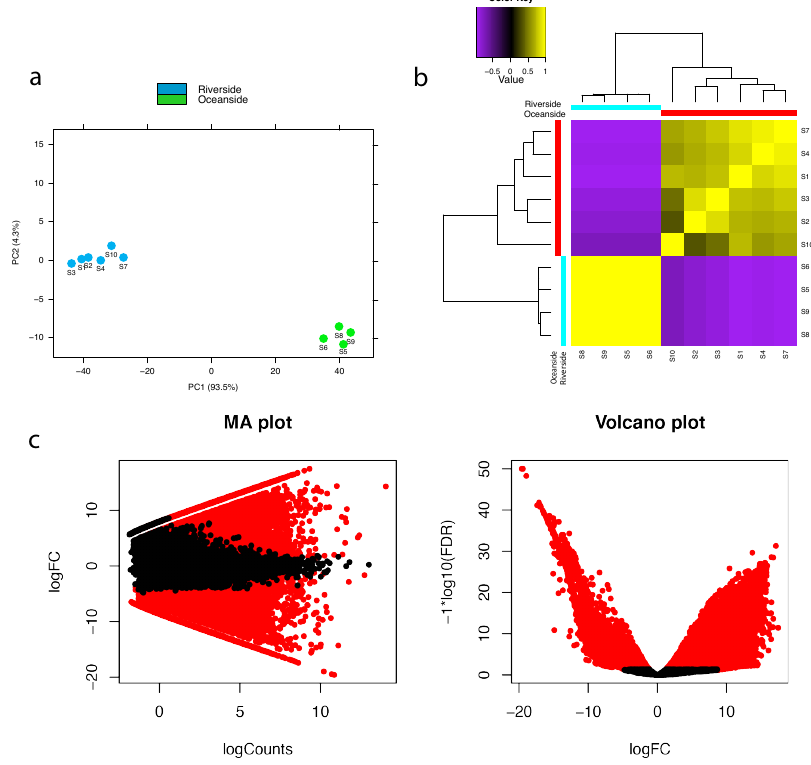
Figure 2. ( a ) Principal component analysis of transcript abundance ( b ) correlation matrix showing relationship between all samples as well as replicates. S1–S4 and S7, S10 are the six replicates from the riverside population and S5, S6, S8, and S9 are the four replicates from the oceanside population. ( c ) Pairwise comparisons of transcript abundance. MA plots showing average log fold change (logFC) vs average log of counts among oceanside vs. riverside transcripts across replicates. Volcano plots showing differentially expressed transcripts in relation to FDR (False discovery rate) for oceanside vs. riverside transcripts. Features found DE at FDR < 0.05 are colored red. Features with p -values at most 1 × 10 − 3 and at least 2 − 2 -fold change are differentially